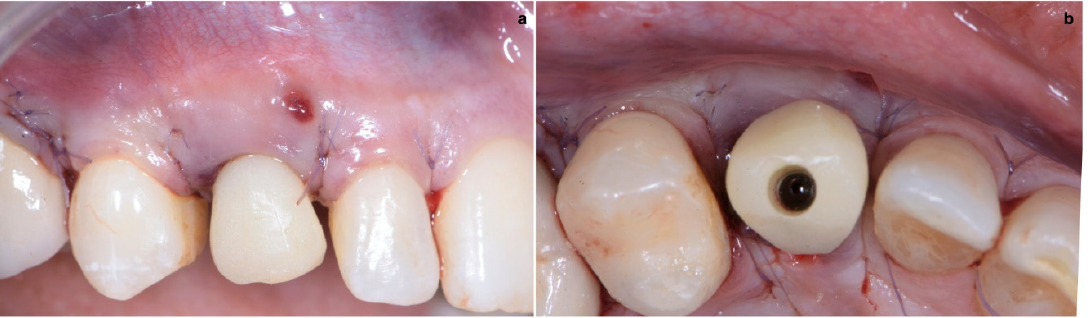
Figure 11. ( a , b ) Suture of the second surgical papilla (the distal one) onto the larger anatomical papilla with a simple interrupted suture, after screwing the provisional.